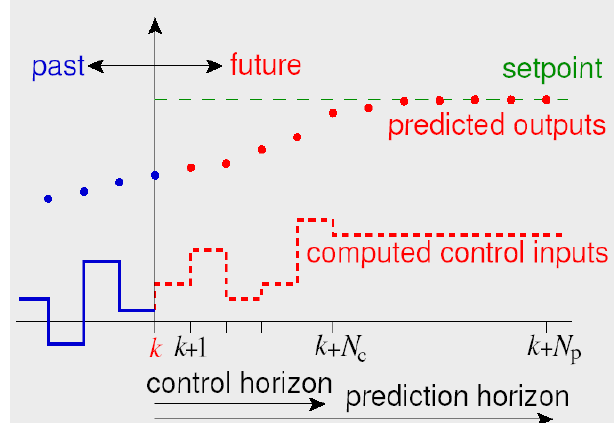
Fig.1. Methodology of MPC.